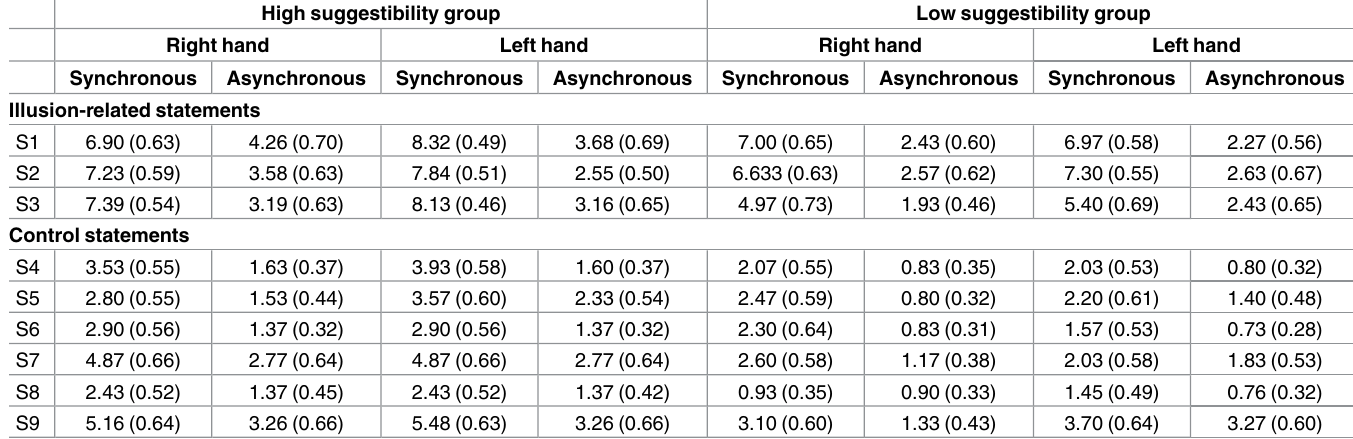
Table 2. Mean ( ± standard error) scores calculated for each illusion-related and control statementin the two groups and for both hands. High suggestibility